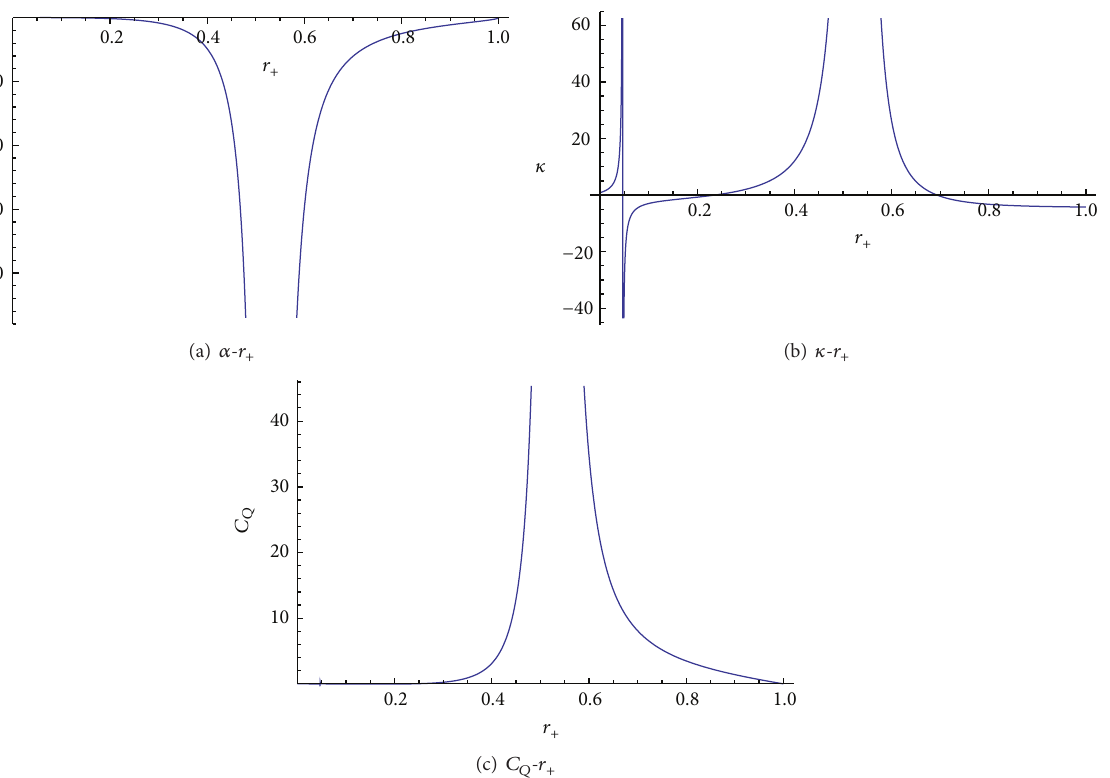
Figure 5: 𝛼 - 𝑟 + , 𝜅 - 𝑟 + , and 𝐶 𝑄 - 𝑟 + curves for higher dimensional charged black hole with 𝑑 = 4